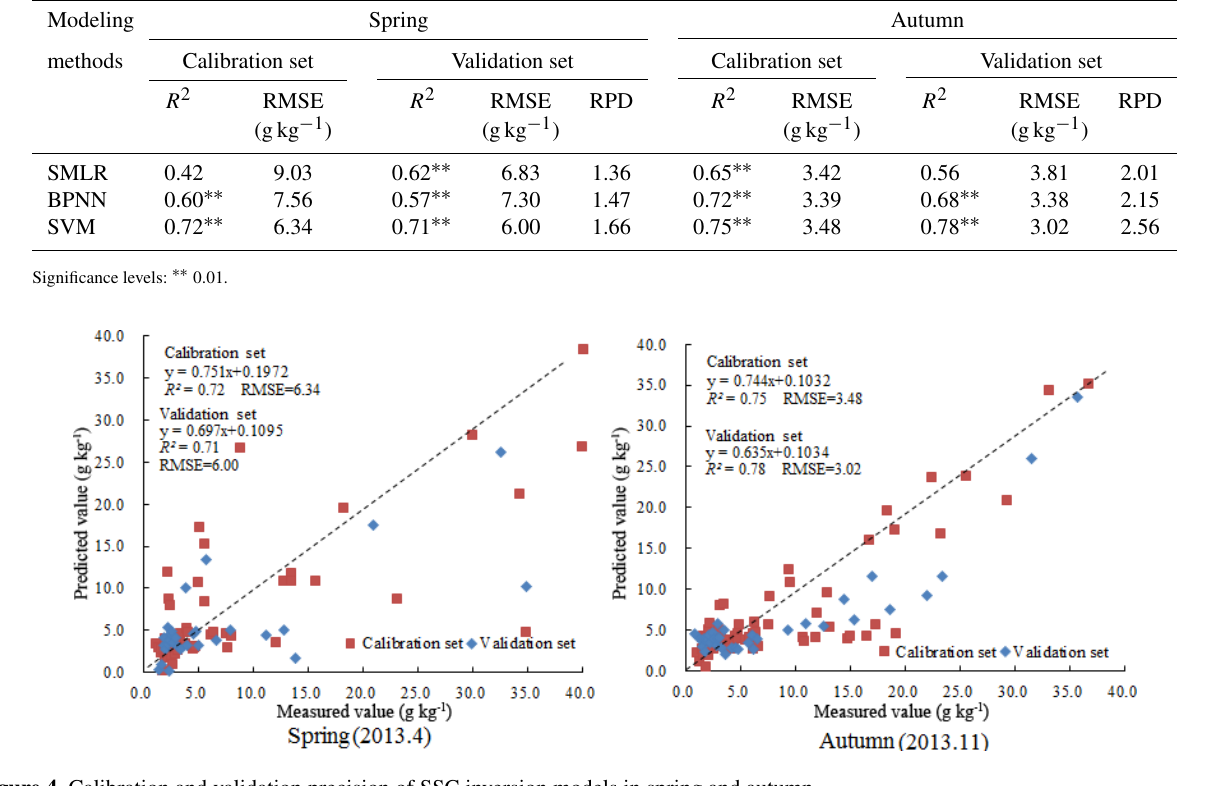
Figure 4. Calibration and validation precision of SSC inversion models in spring and autumn.